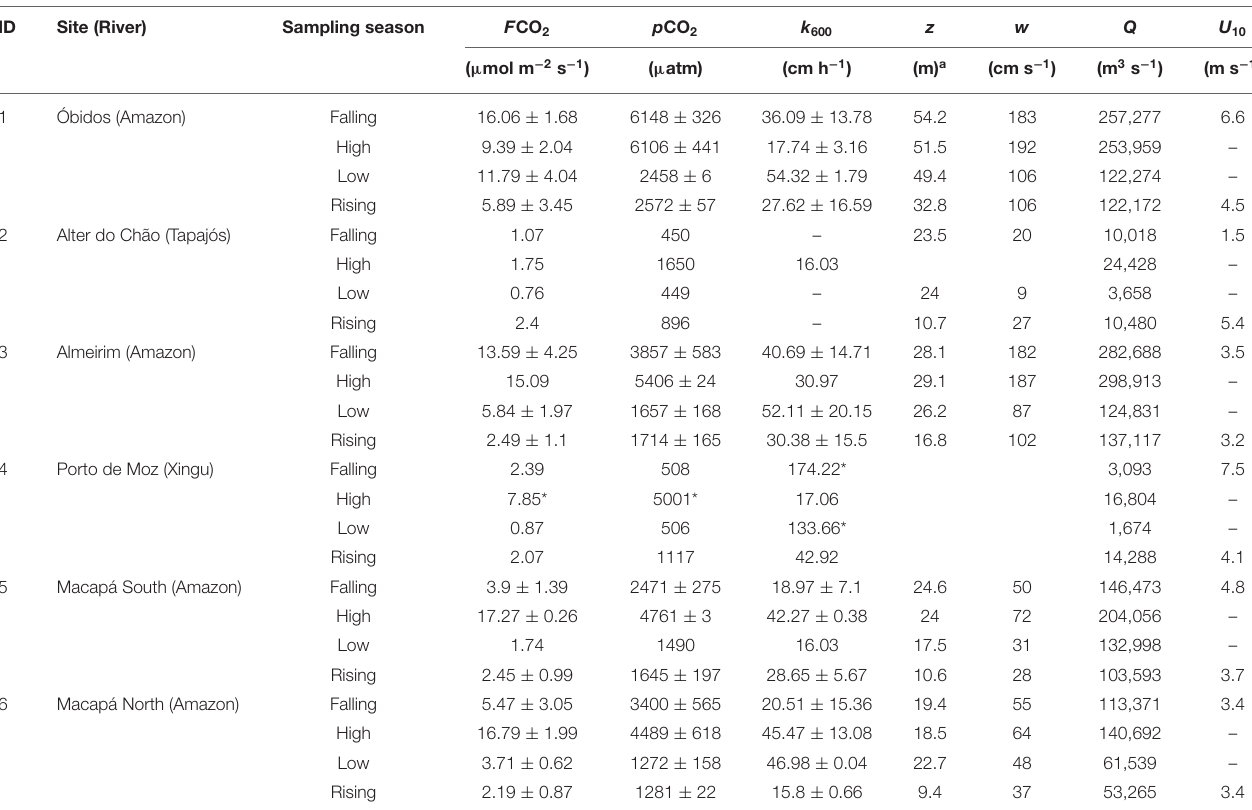
TABLE 1 | CO 2 fluxes to atmosphere ( F CO 2 ), partial pressure of CO 2 in the water ( p CO 2 ), gas transfer velocity ( k 600 ) measurements according to site and season (mean ± SD) and measurements of mean depth ( z ), water velocity ( w ), discharge ( Q ) and wind speed ( U 10 ).